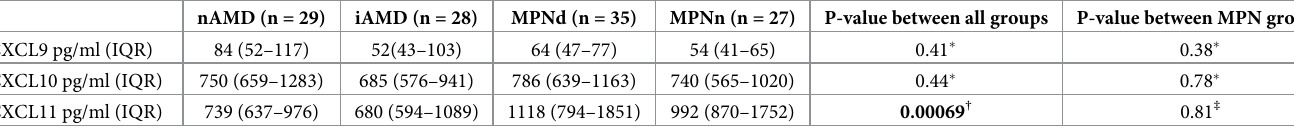
Table 3. Median plasma concentration of CXCL9, CXCL10, and